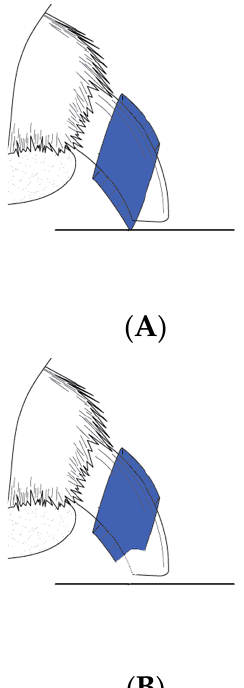
Figure 1. ( A ) Nail grip (Dr. Buzby’s ToeGrips ® , Beaufort, SC, USA) with intact ventral grip surface contact. ( B ) Sham grip with coved ventral surface preventing floor surface contact.